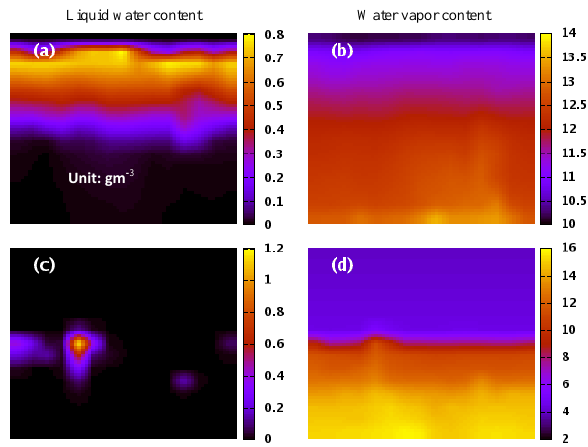
Figure 2. The cloud liquid water and water vapor fields of a stratocumulus case (ASTEX) and a puffy cumulus case (ATEX) simulated by a large eddy simulation model (Ackerman et al., 1995). (a) Stratocumulus case, liquid water; (b) Stratocumulus case, water vapor; (c) Puffy cumulus case, liquid water; and (d) Puffy cumulus case, water vapor. The domain is 5 km wide and 2.5 km high.